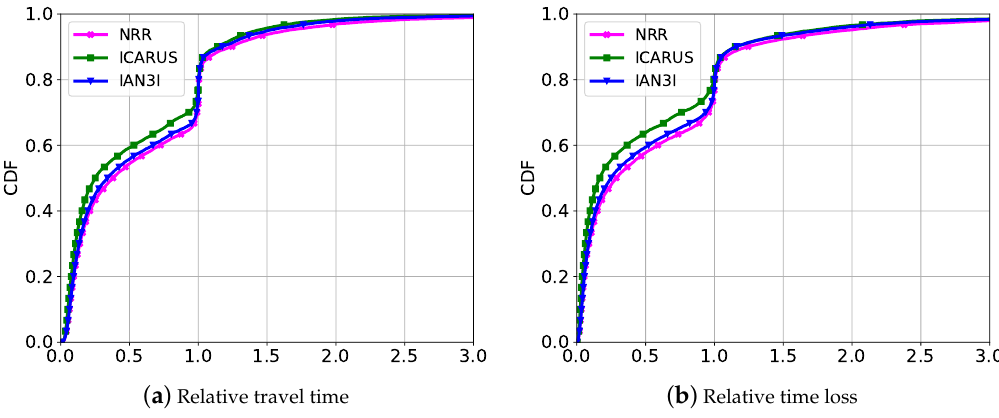
Figure 7. Traffic efficiency results using relative metrics for dealing with unexpected traffic